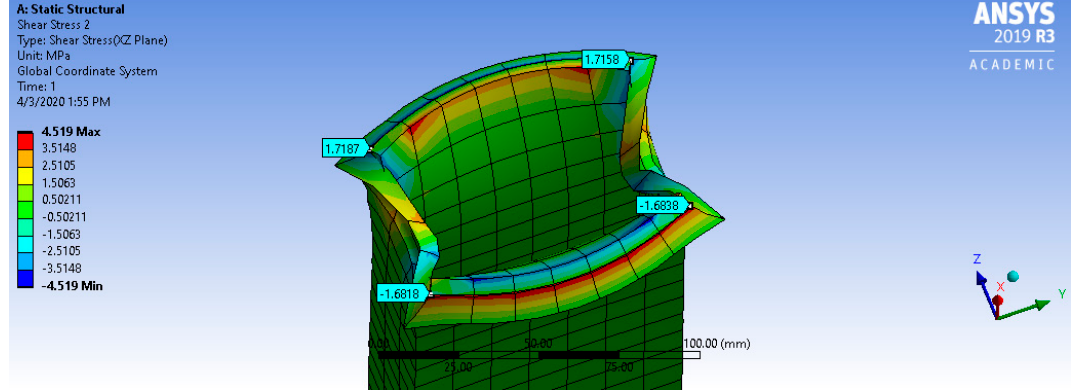
Figure 18. Shear stress at the interface between the glass sheets and HDPE for the 89 × 38 × 3 × 4 GRCC. Similar to the previous two examples, a third (Figure 19) is shown; this is the 150 × 150 × 3 × 3 GRCC at the buckling load. Note that these stresses are less than the worst case from Figure 17 above.